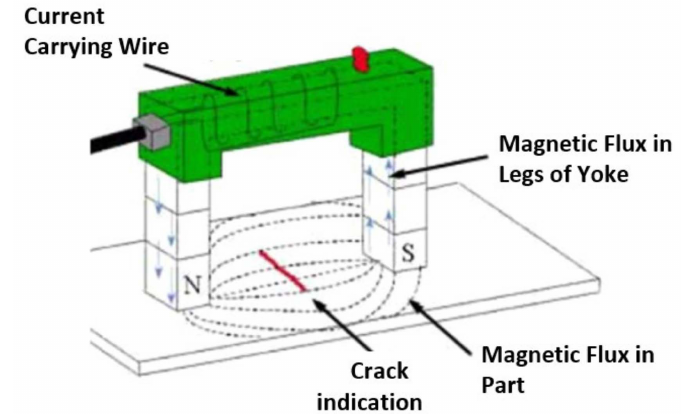
Figure 6. Producing a magnetic field using the yoke in the test piece [21].